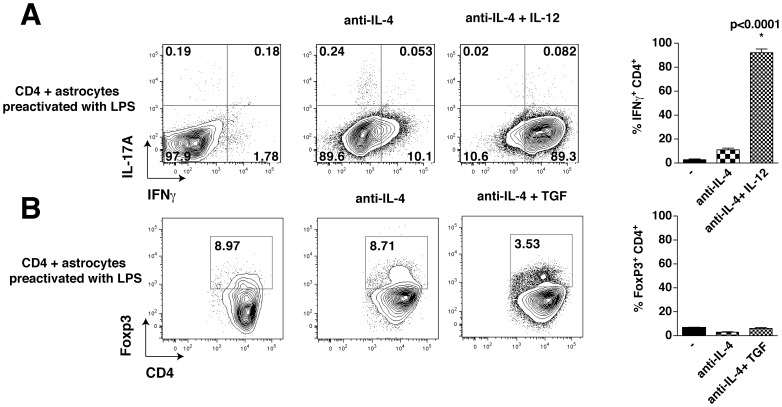
Preactivation of astrocytes reduces Th1 differentiation.CD4+ T cells were cultivated for 4 days on a monolayer of astrocytes that were pre-activated with LPS for 18 h, with or without 10 µg/mL anti-IL-4 and 10 ng/mL IL-12 where indicated. IFNγ-producing (A) and Foxp3 expressing (B) CD4+ T cells were analyzed by flow cytometry after restimulation with ionomycin/PMA/BFA for 4 h. Flow cytometry analyses were quantified and expressed as mean ± s.e.m. (for the data in A: n = 3, one-way ANOVA test, *p<0.05; for the data in B: n = 2–4).